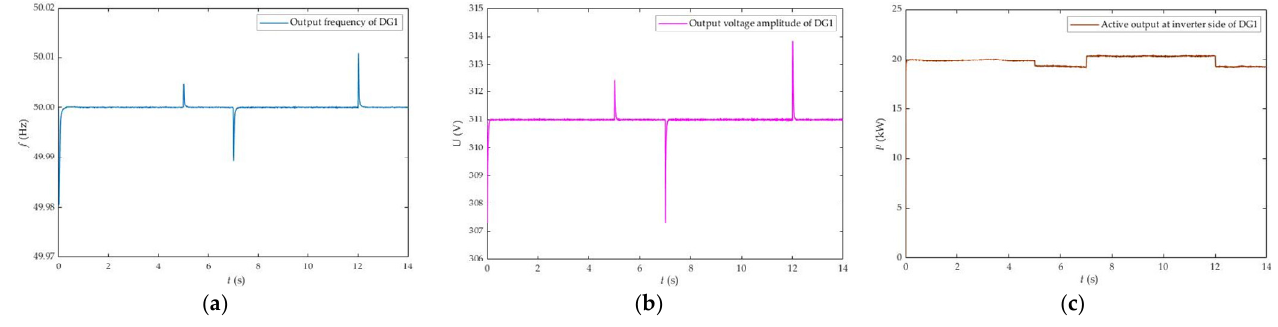
Figure 9. Change curves of output frequency, output voltage amplitude, active output at inverter side of DG1: ( a ) change curve of output frequency of DG1; ( b ) change curve of output voltage amplitude of DG1; ( c ) change curve of active output at inverter side of DG1.